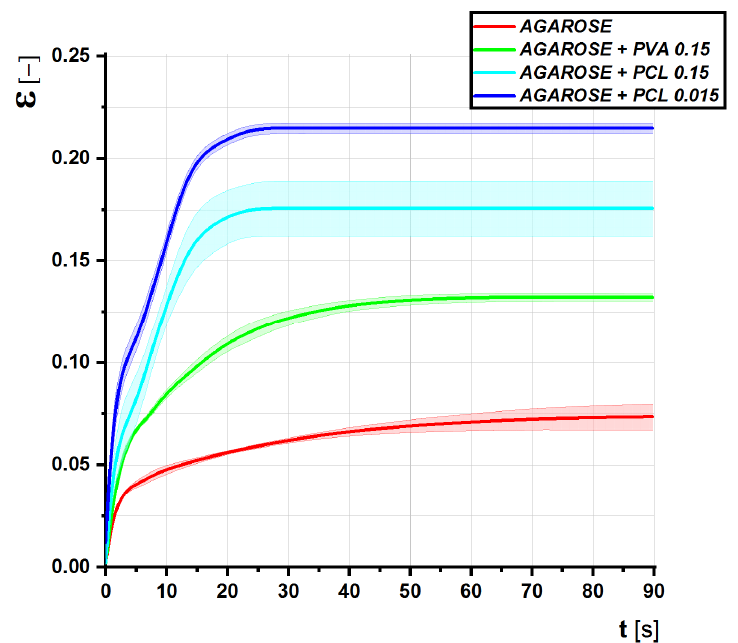
Figure 7. Graph of relative elongation versus time at constant internal stress for individual types of gel (creep).